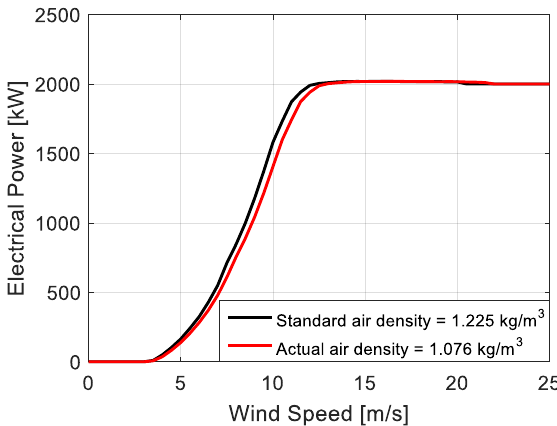
Figure 8. Comparison of the power curve of standard air density and the power curve of actual air density.